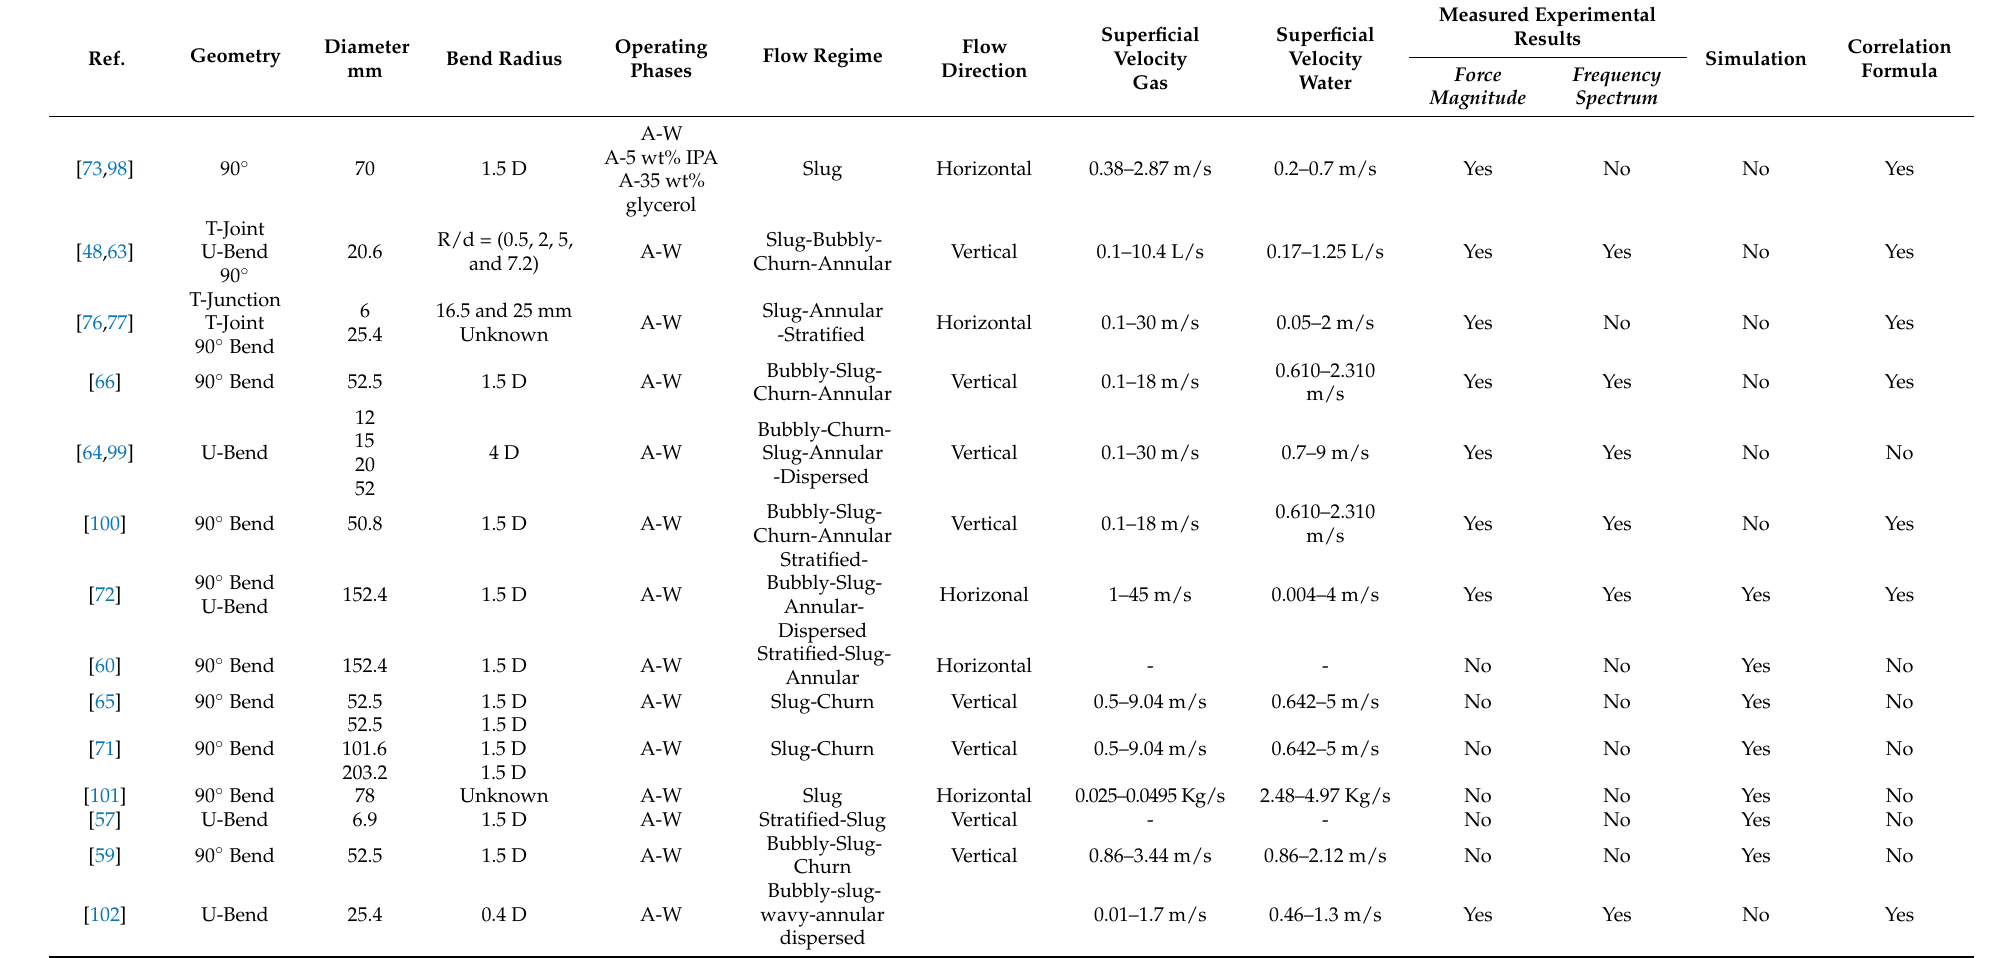
Table 1. Summary of existing database on flow-induced